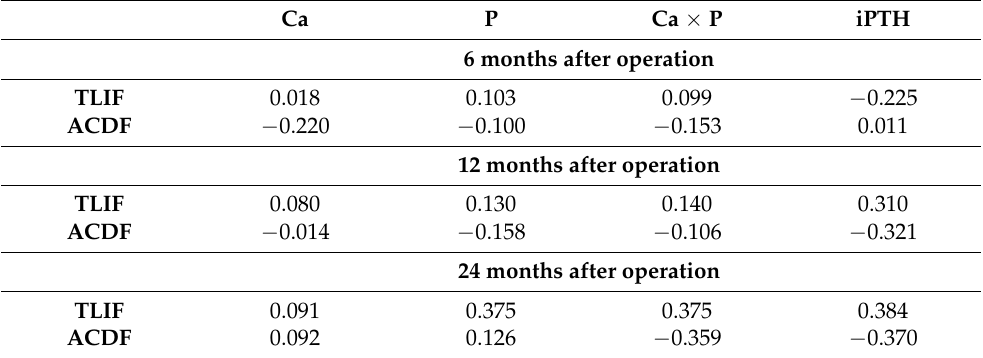
Table 2. Correlation between fusion grades and serum level of Ca, P, Ca × P, and iPTH in TLIF and ACDF groups.